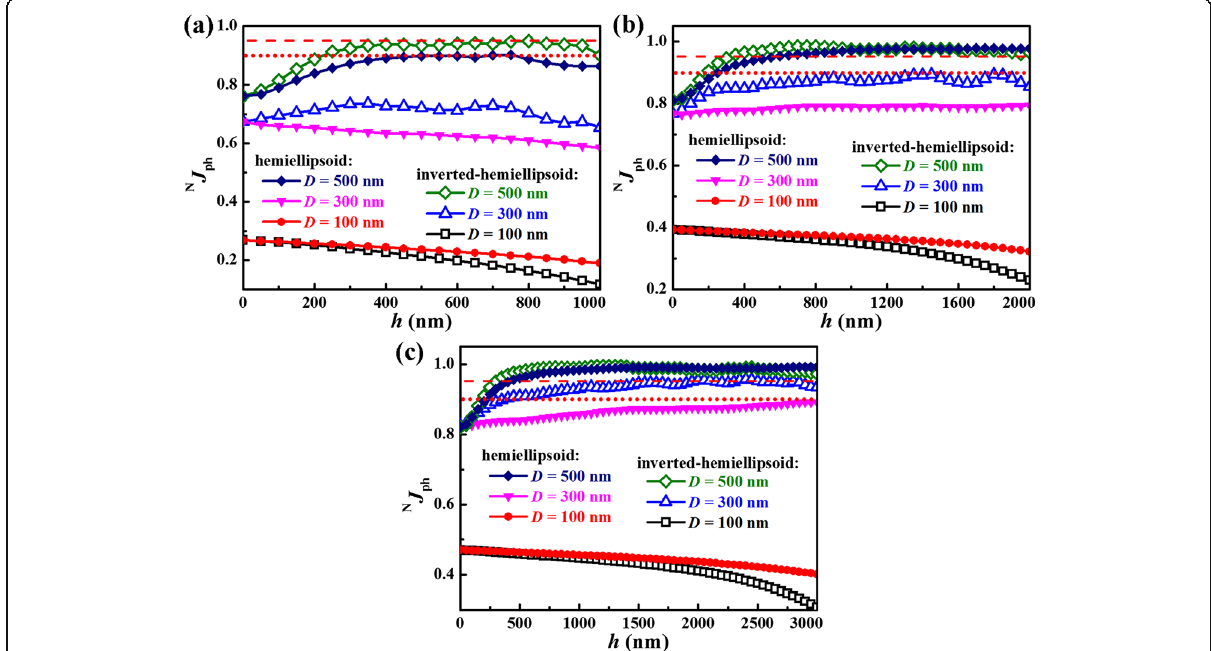
Fig. 2 Normalized theoretical photocurrent density ( N J ph ) for the hemiellipsoid- and inverted hemiellipsoid-modified GaAs NW arrays as a function of the hemiellipsoid height ( h ) at different total heights of a 1000, b 2000, and c 3000 nm. The wire diameters ( D ) are 100, 300 and 500 nm. The red dot line and red dash line in each figure denote the values of N J ph of 0.90 and 0.95,